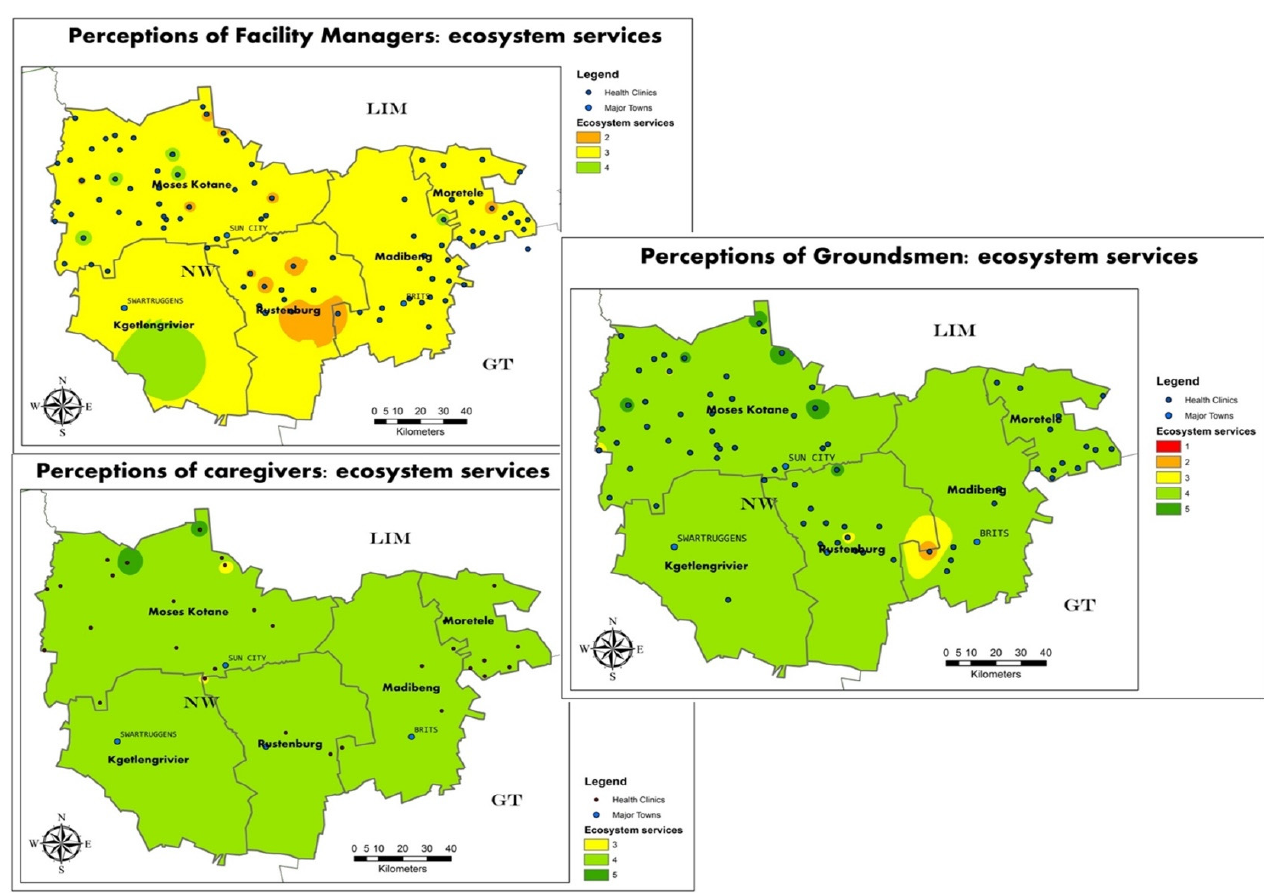
Figure 4. Perceptions of ES at health clinic gardens among facility managers, caregivers, and groundsmen in the Bojanala district. Red and orange areas indicate a low score and less positive perception, while green areas indicate high scores and positive perceptions.